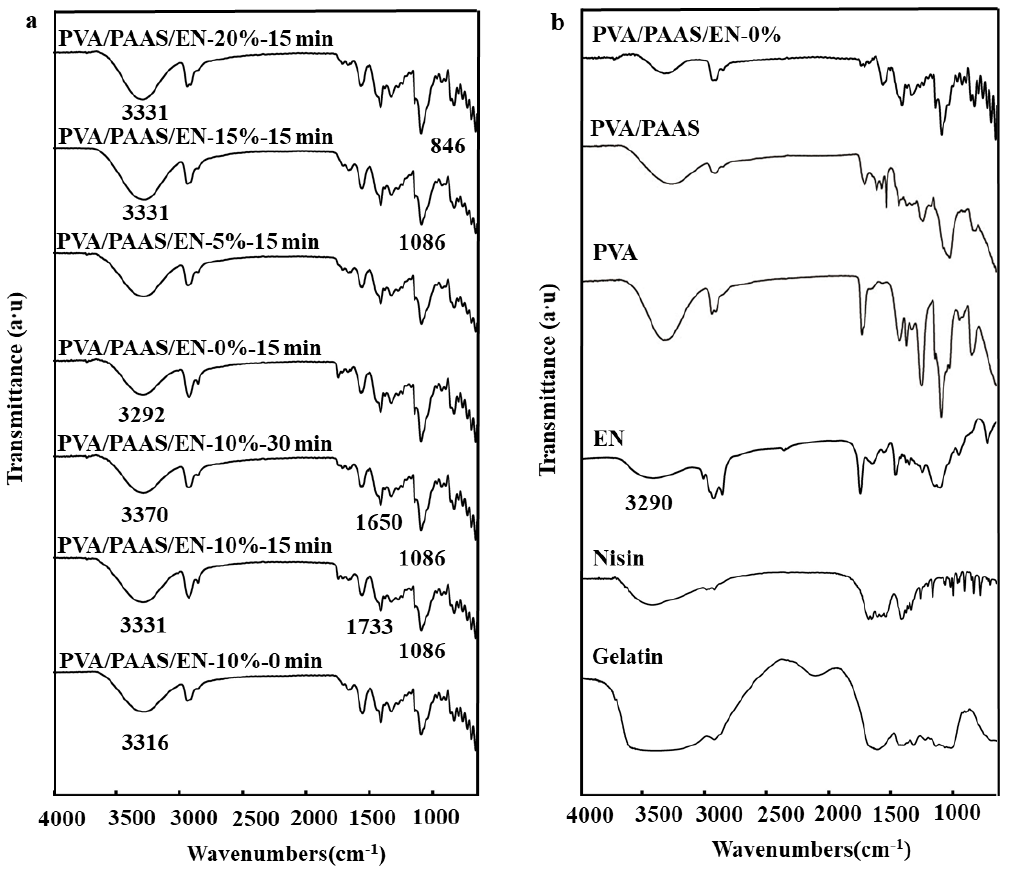
Figure 3. ( a ) FTIR spectra of typical PVA/PAAS/EN-10% nanofibers under different ultrasound times, and PVA/PAAS/EN nanofibers with different EN concentration (under 15 min of ultrasonic treatment); ( b ) FTIR spectrum of PVA/PAAS/EN-10%, PVA/PAAS, PVA, EN, Nisin, Gelatin.